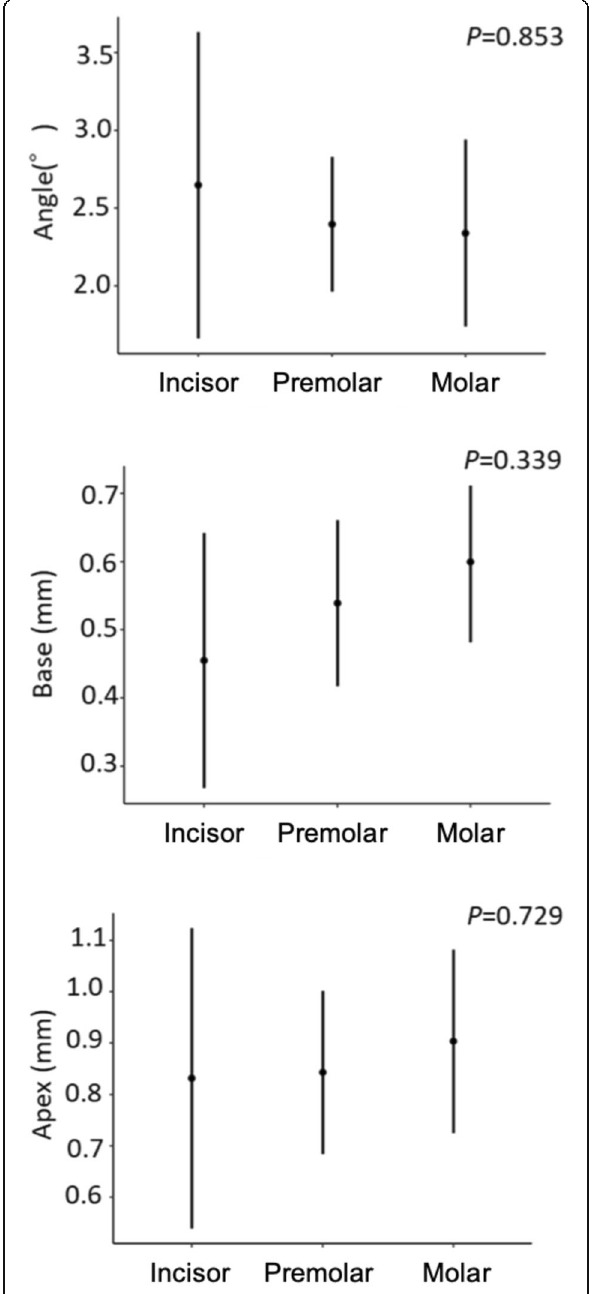
Fig. 6 The errors caused by differences in type of tooth. Error bars indicate 95% confidence intervals